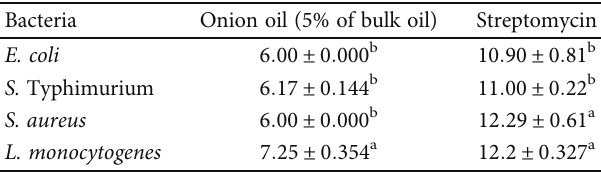
Figure 1: The e ff ect of various concentrations of sodium caseinate as an emulsi fi er on droplet size (a), emulsion stability (b), turbidity (c), lightness (d), and chroma (e). Values are means ± standard deviations ( n = 3 ). Di ff erent letters show statistically signi fi cant di ff erences between values ( p < 0 : 05 ). con.: concentration. Table 2: The clear zone inhibition diameter (mm) of onion essential oil against selected